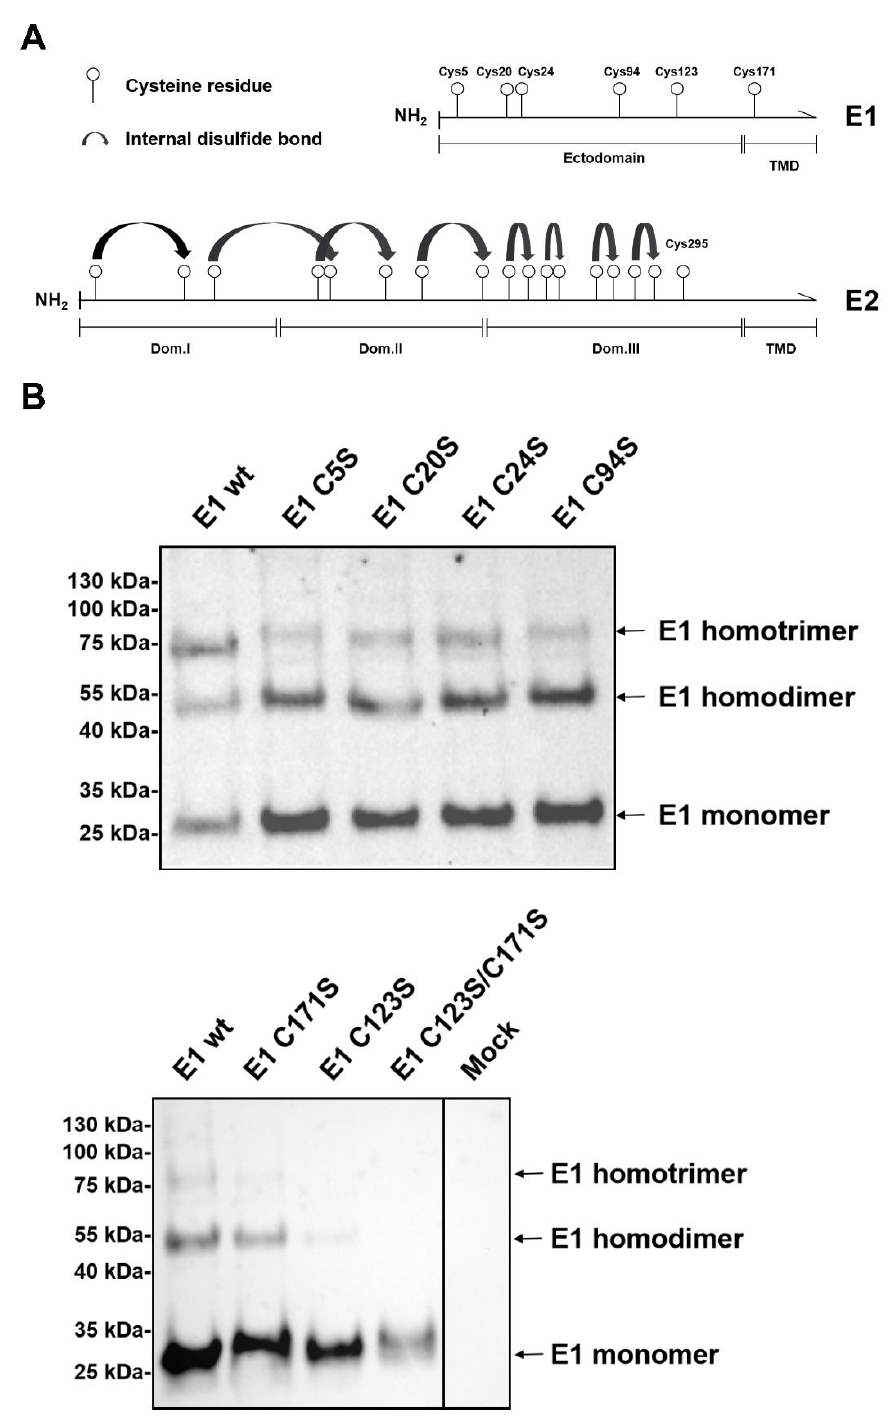
Figure 2. Both C123 and C171 play an important role in E1 homooligomerization. ( A ) Schematic representation of the distribution of cysteine residues in the E1 and E2 proteins of pestiviruses (BVDV CP7 as an example). Numbered circles represent the positions of the Cys residues in E1 and E2. Curved black arrows indicate internal disulfide bonds identified during E2 3D structure determination [17,18]. ( B ) The given constructs coding for HA-tagged E1 wt and mutants with Cys to Ser exchanges were transfected into RK-13 cells and expression products were analyzed via western blot. The cells were lysed and separated by SDS-PAGE under nonreducing conditions. Western blot analysis was carried out using primary antibody α-HA and secondary antibody anti-rabbit-PO for the detection of proteins. A file is provided in the Supplementary Materials with the original western blot results to demonstrate that the two parts of the lower panel were derived from one gel.